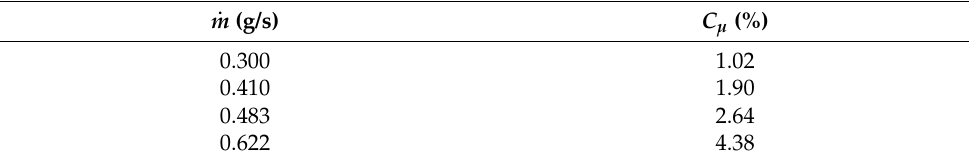
Table 5. C µ values according to mass flow